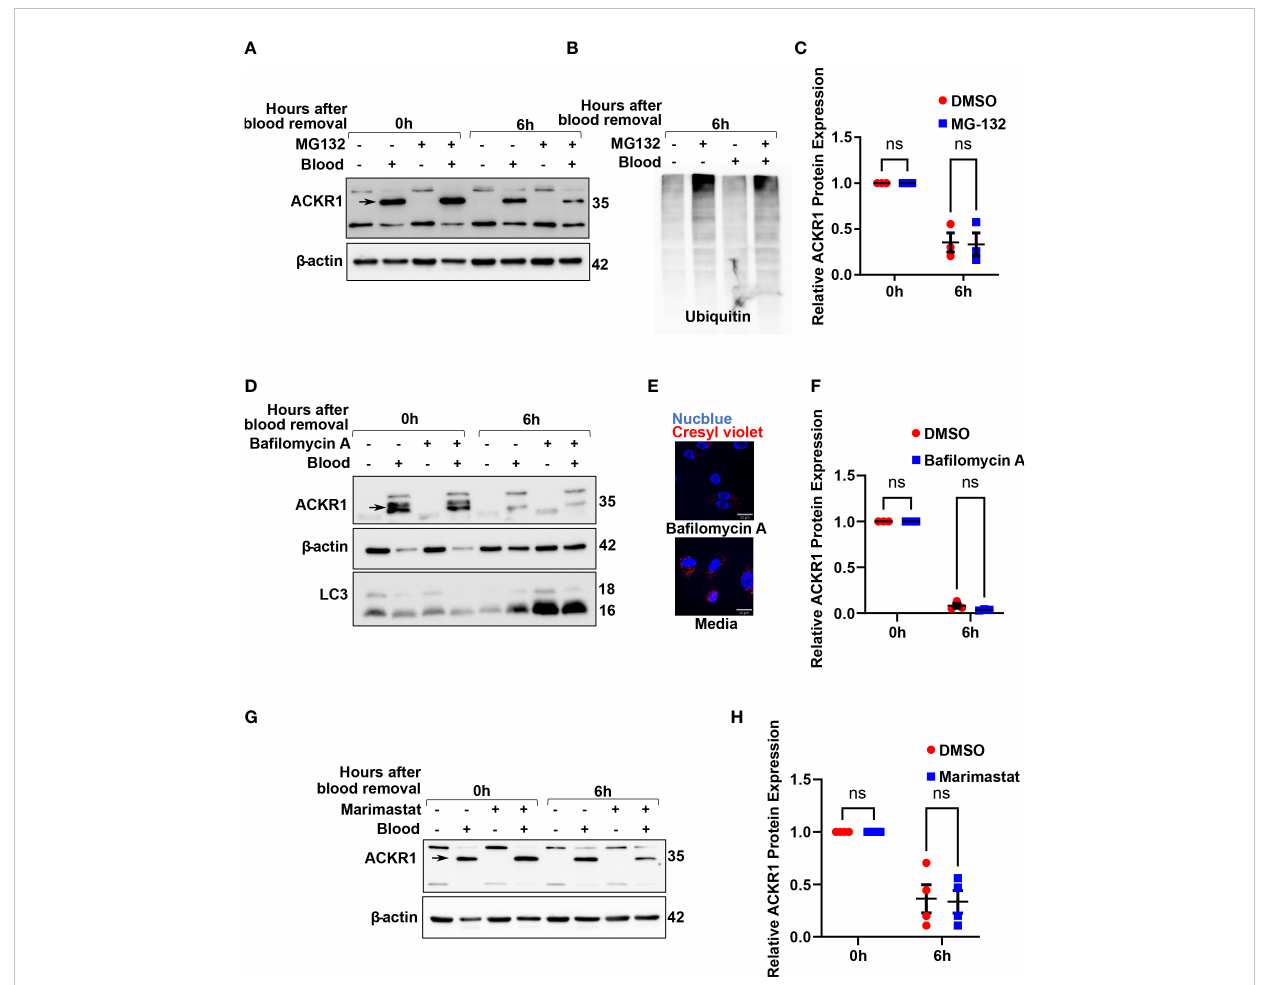
FIGURE 6 Inhibition of the proteasome, lysosomes/autophagy and metalloproteases do not prevent loss of ACKR1 from endothelial cells. (A, B) HPMECs were pre- incubated with blood for 24 hours and subsequently washed and incubated with media containing the proteasome inhibitor MG132 at 20 m M for 6 hours. Immunoblotting was used to assess ACKR1 protein (using the Ab58965 antibody) and ubiquitin levels. (C) Quanti fi cation of ACKR1 protein, normalized to b -actin. (D) Lysosomes and autophagy were inhibited with Ba fi lomycin A (100 nM) for 6 hours after blood removal. Immunoblotting was used to assess ACKR1 protein; LC3 is a control for autophagy. (E) Lysosomes were stained with Cresyl violet in live cells with or without Ba fi lomycin A treatment. (F) Quanti fi cation of ACKR1 protein, normalized to b -actin. (G, H) Cells were treated with Marimastat (100 m M) after blood removal to inhibit matrix metalloproteases; ACKR1 protein level was normalized to b -actin. ns means not signi fi